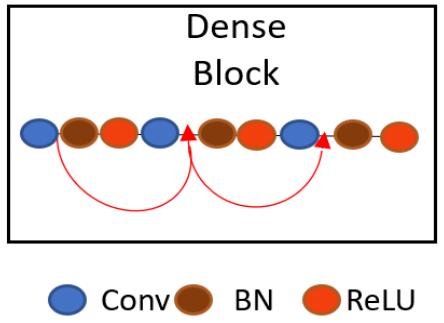
Figure 3. Dense connectivity within the dense block by feature concatenation.